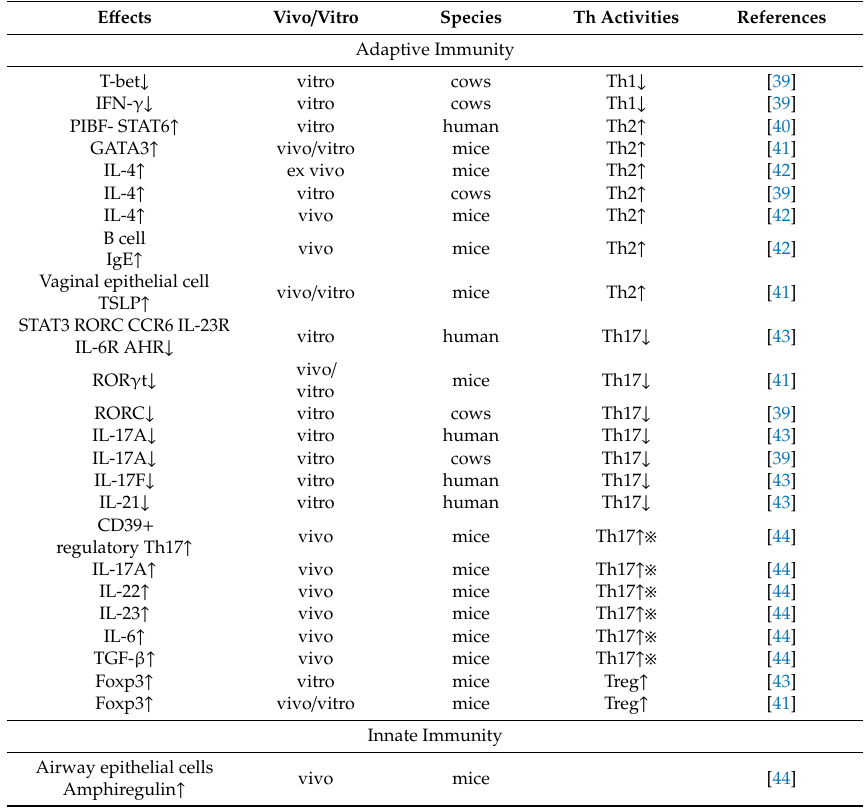
Table 3. Summary of the e ff ects of progesterone on the activities of T helper 1 cell (Th1), Th2, Th17, and regulatory T cell